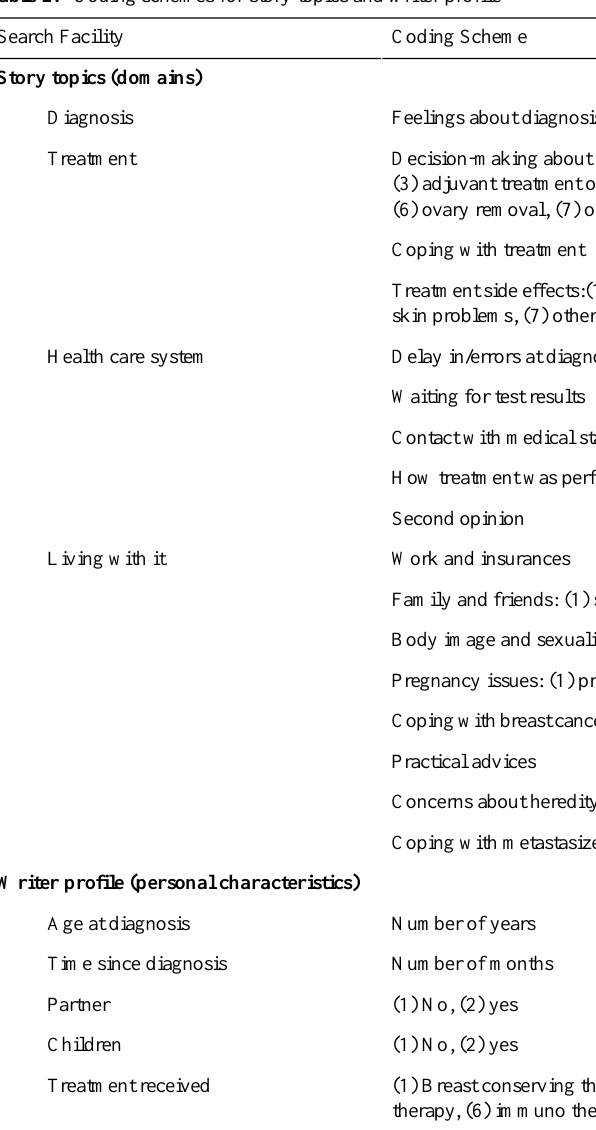
Table 2. Coding schemes for story topics and writer profile